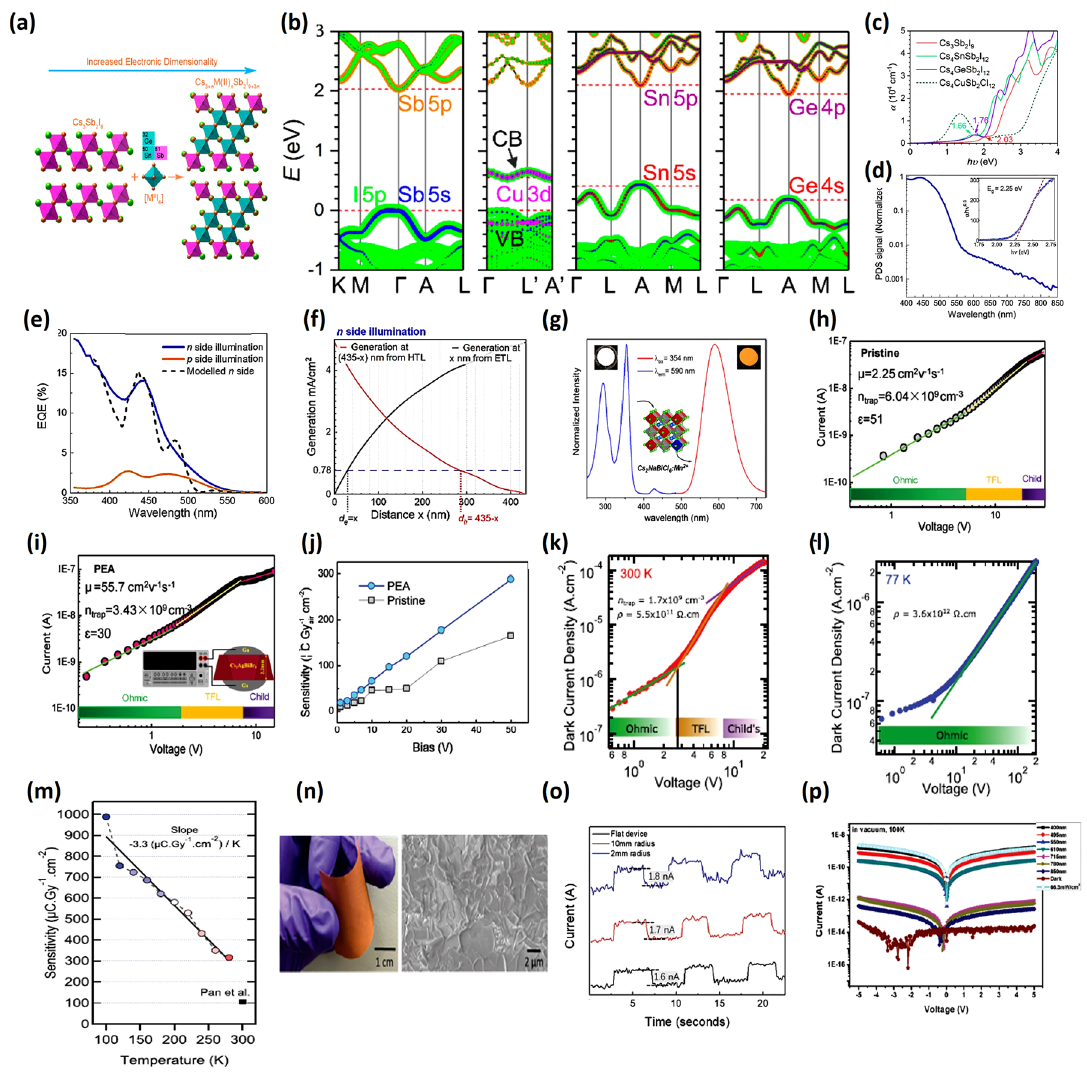
Figure 10: (a) General design principle for the layered halide double perovskites Cs 3 + n M 2 + n Sb 2 X 9 + 3 n (M = Sn, Ge) [166]. Copyright 2018, American Chemical Society. (b) Calculated band structures of Cs 3 Sb 2 I 9 , Cs 4 CuSb 2 I 12 , Cs 4 SnSb 2 I 12 and Cs 4 GeSb 2 I 12 from left to right [166]. Copyright 2018, American Chemical Society. (c) Calculated absorption spectra of Cs 3 Sb 2 I 9 , Cs 4 SnSb 2 I 12 , Cs 4 GeSb 2 I 12 and Cs 4 CuSb 2 Cl 12 [166]. Copyright 2018, American Chemical Society. (d) Photothermal de fl ection optical absorption spectroscopy (PDS) spectrum of neat Cs 2 AgBiBr 6 thin- fi lm.Inset: Tauc plotwith the calculated indirectband-gapreported[179].Copyright2020, American ChemicalSociety.(e)EQEmeasured withilluminationfromtheITO(bluecurve),fromthegold(orangecurve)andthemodelled n -EQE(blackdashedcurve)[179].Copyright©2020, American Chemical Society. (f) Current generation at a distance x from the ETL (black curve) and a distance 435 − x from the HTL (red curve) in the case of n-side illumination [179]. Copyright © 2020, American Chemical Society. (h) Excitation (blue) and emission (red) scans